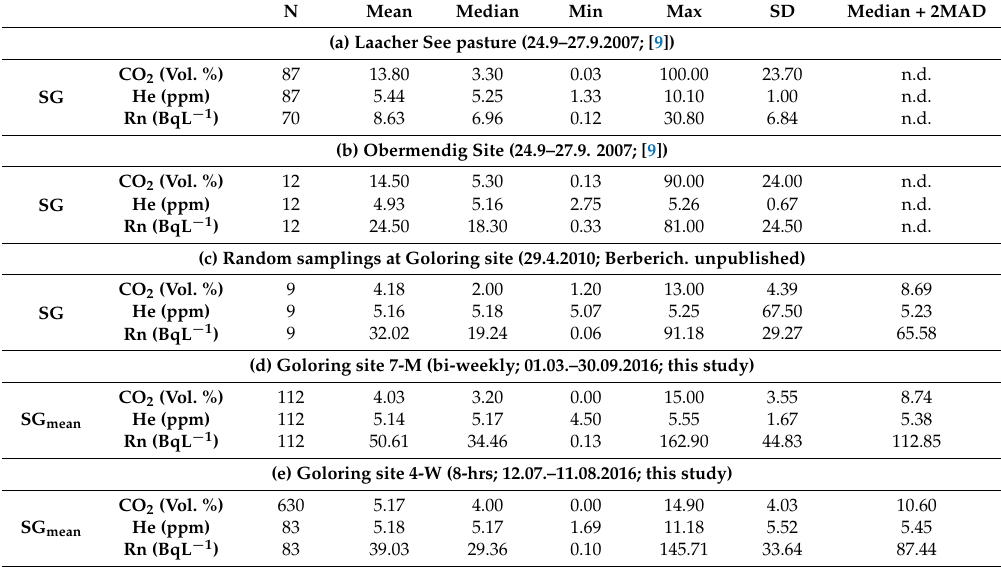
Table A5. Comparison of gas concentrations in SG gas (a) from gas vents at Laacher See pasture (2007; [9]); (b) Obermendig Site (2007; [9]); (c) random samplings at Goloring site (2010; Berberich. unpublished); and average values of SG1–SG7 (SG mean ) of the 7-M (d) and 4-W samples (e) at Goloring (2016; this study). n.d. = not determined. N